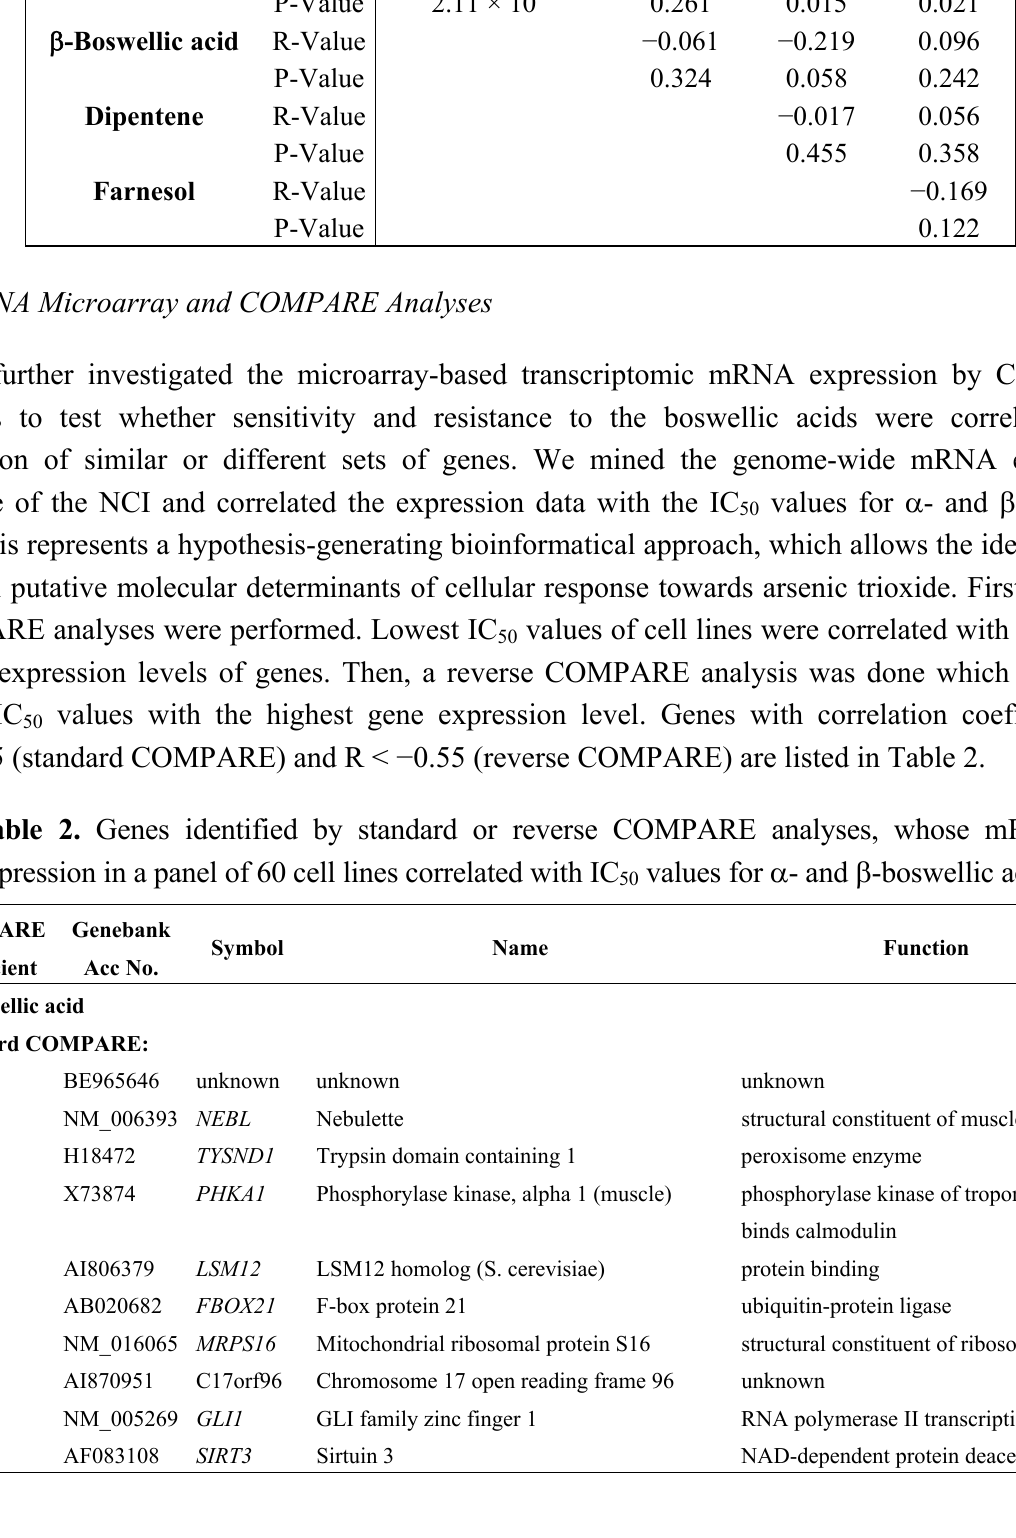
Table 1. Cross-resistance profile of a panel od cell lines towards five phytochemicals from Boswellia carterii determined by correlating the IC